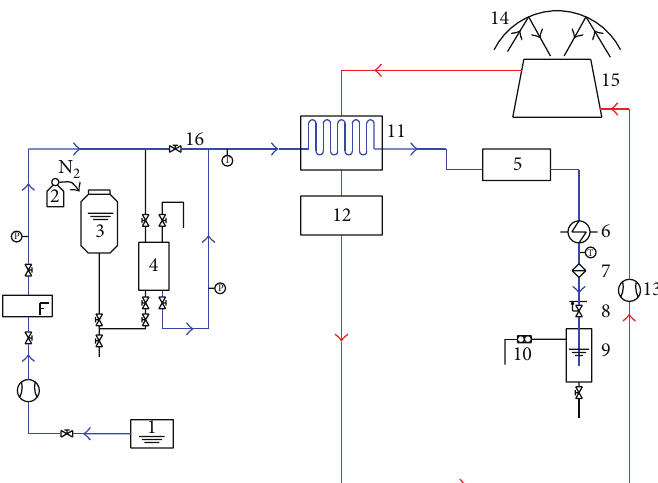
Figure 1: Hydrogen production without preheating process (Method 1). (1) water tank, (2) nitrogen tank, (3) storage tank, (4) feeder, (5) regenerator, (6) cooler, (7) filter, (8) back pressure regulator, (9) gas-liquid separator, (10) wet gas flow meter, (11) high temperature